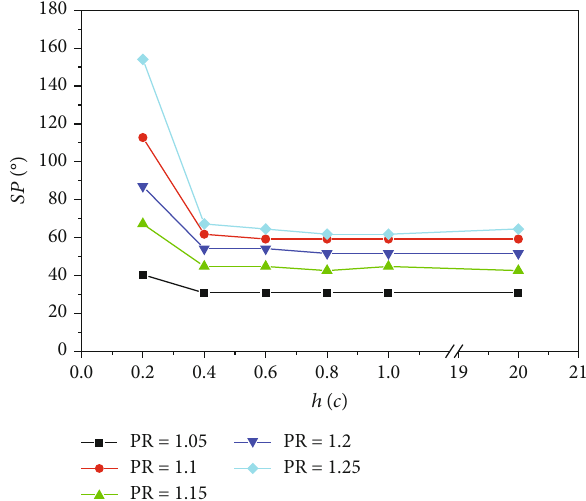
Figure 18: Curves of separation angle versus ride height for lower slot blowing with α = 0 °